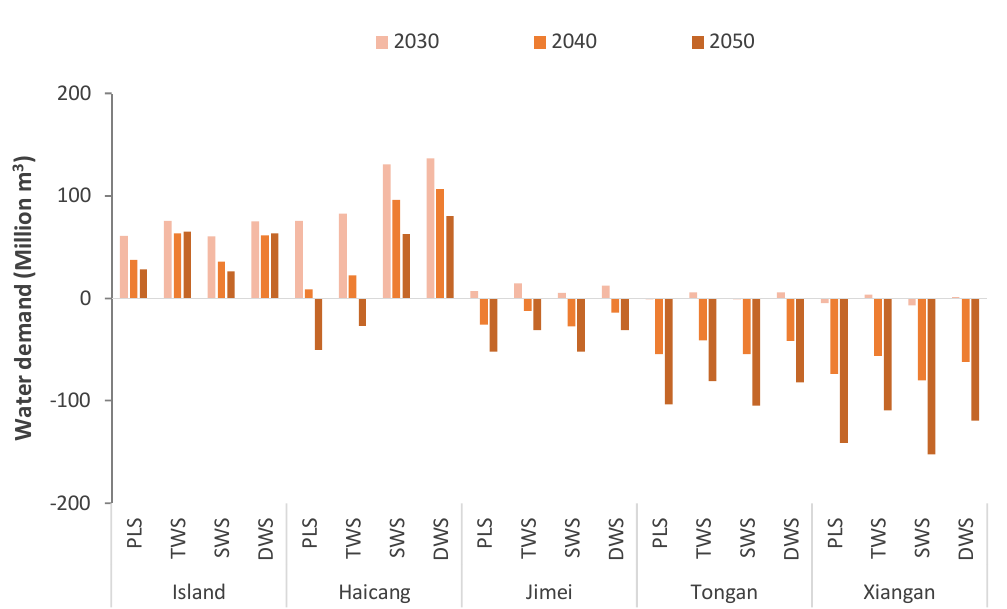
Figure 5. Waterworks capacity deficits in each Xiamen City district under different scenarios. Note: PLS is the acronym for planning scenario; TWS is the acronym for technical water-saving scenario; SWS is the acronym for structural water-saving scenario; DWS is the acronym for double water-saving scenario.